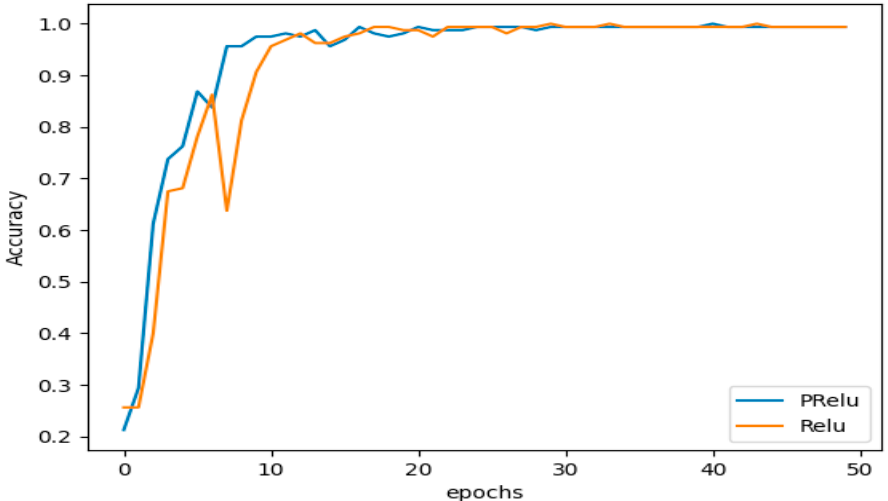
Figure 15. Variation in accuracy with iteration number under different activation functions.